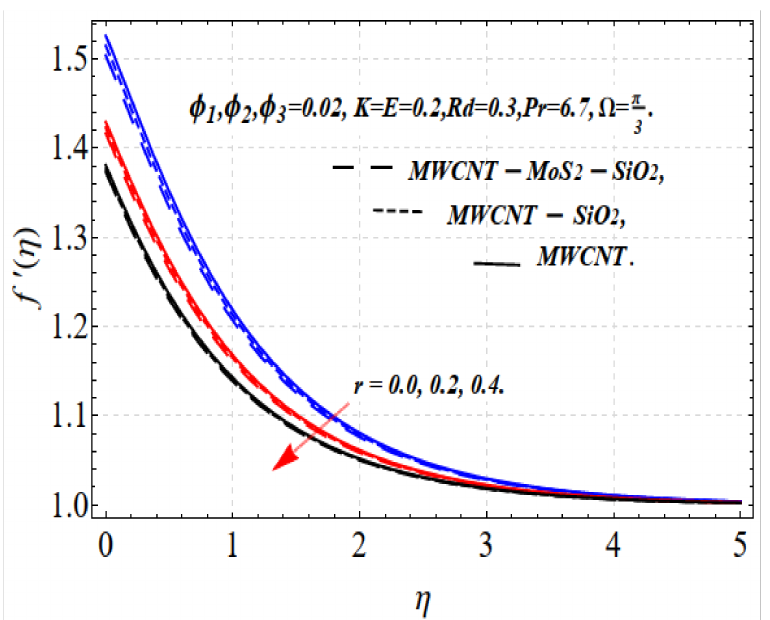
Figure 3. f (cid:48) ( η ) vs. r